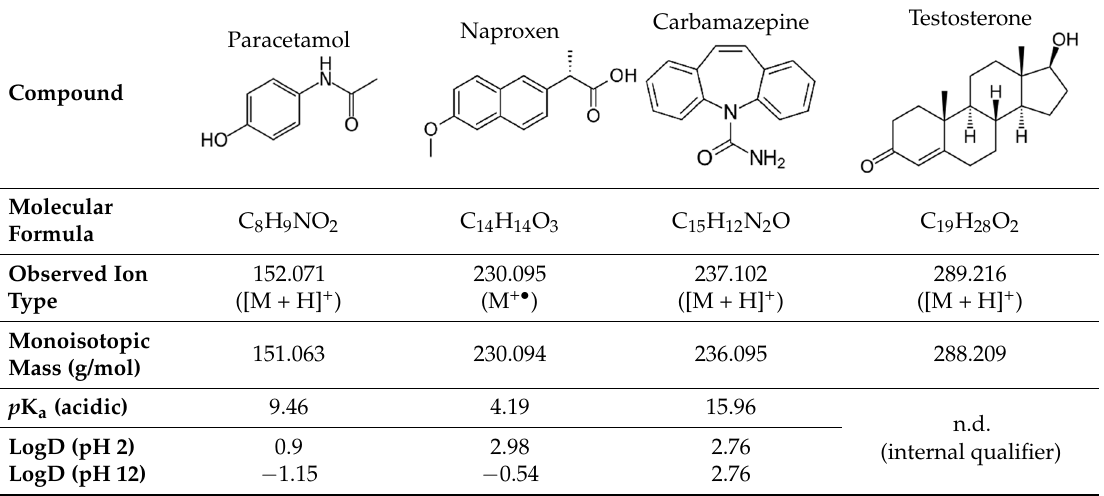
Table 1. The chemical structures, monoisotopic masses and chemical properties of the model pharmaceuticals used. Molecular properties from Chemicalize (https://chemicalize.com/) developed by ChemAxon Ltd. (Budapest, Hungary).